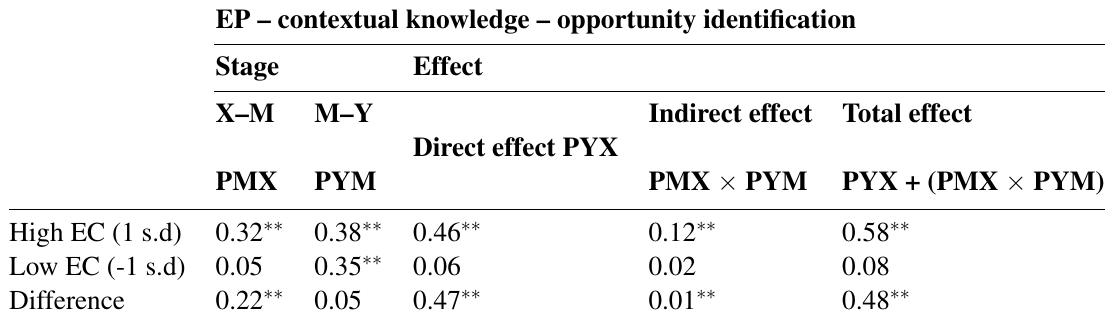
Table 5 Moderate path analysis